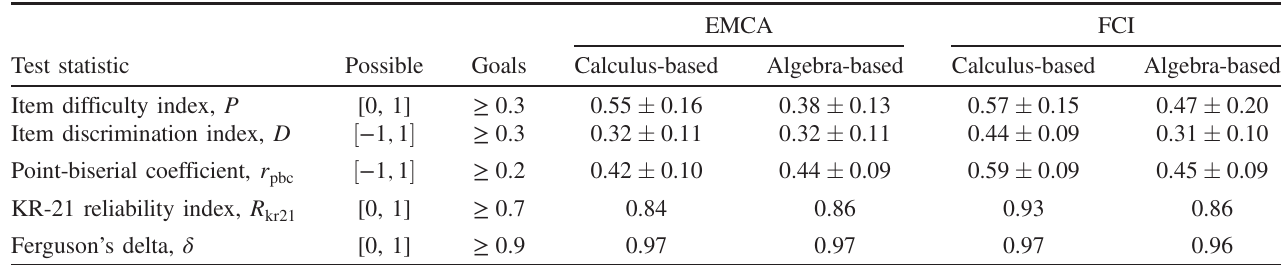
TABLE IV. Post-test statistics of assessment. (Average and standard deviation results are given for the EMCA and FCI assessments for the Siena College calculus- and algebra-based